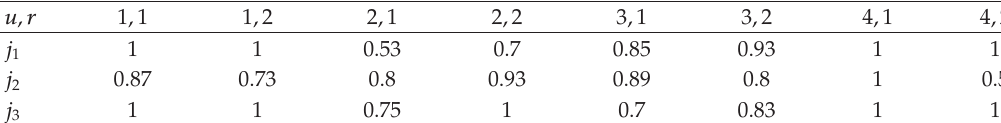
Table 6: Passenger